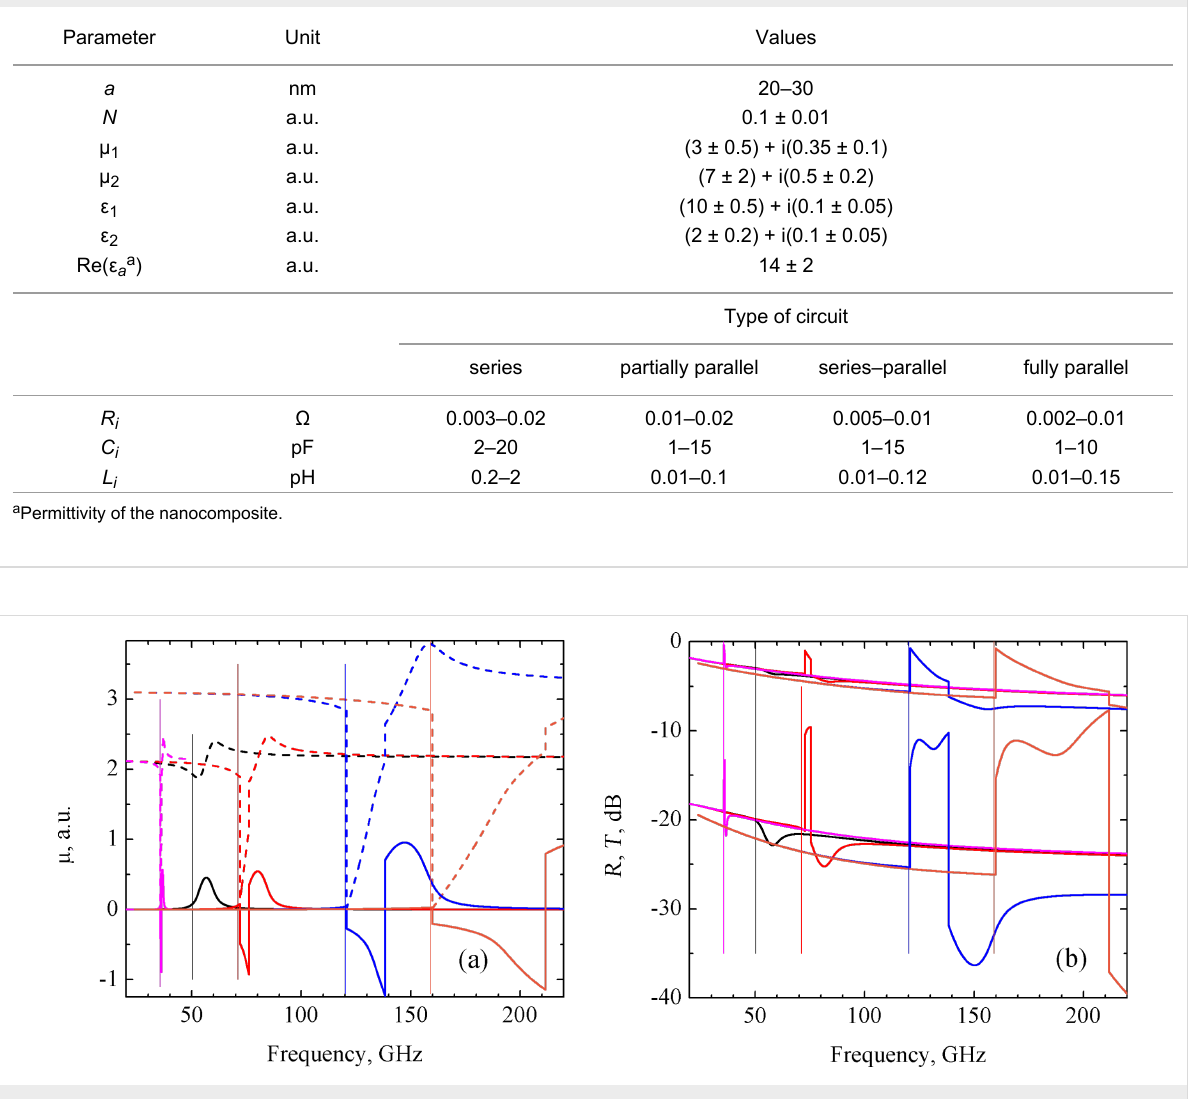
Figure 1: Frequency dependence of the real (dashed lines) and imaginary (solid lines) parts of the permeability (a), and of the reflection, R (upper curves), and transmission, T (lower curves), coefficients (b) for the CNT-based nanocomposite consisting of a series R i L i C i circuit. From left to right: R i = 0.015 Ω , L i = 2 pH, C i = 10 pF ( ω 0 = 35.6 GHz) (magenta lines); R i = 0.015 Ω , L i = 0.5 pH, C i = 20 pF ( ω 0 = 50.3 GHz) (black lines); R i = 0.015 Ω , L i = 0.5 pH, C i = 20 pF ( ω 0 = 71.2 GHz) (red lines); R i = 0.012 Ω , L i = 0.35 pH, C i = 5 pF ( ω 0 = 120.3 GHz) (blue lines); R i = 0.012 Ω , L i = 0.2 pH, C i = 5 pF ( ω 0 = 159.1 GHz) (orange lines). The resonance frequency of the R i L i C i circuit, ω 0 , is represented by a vertical line of corresponding